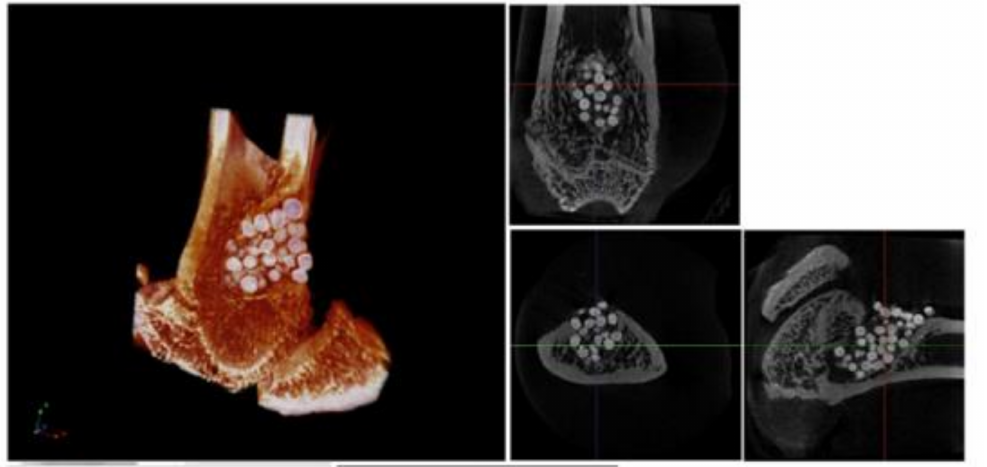
Figure 6. Micro-CT analysis of distal femur after 60 days of implantation. 3D reconstructed image and respective orthogonal slices of micro-CT acquisition of the femur with Sr-hybrid filled defect. (Adapted with permission from [40]. Copyright (2021) National Library of